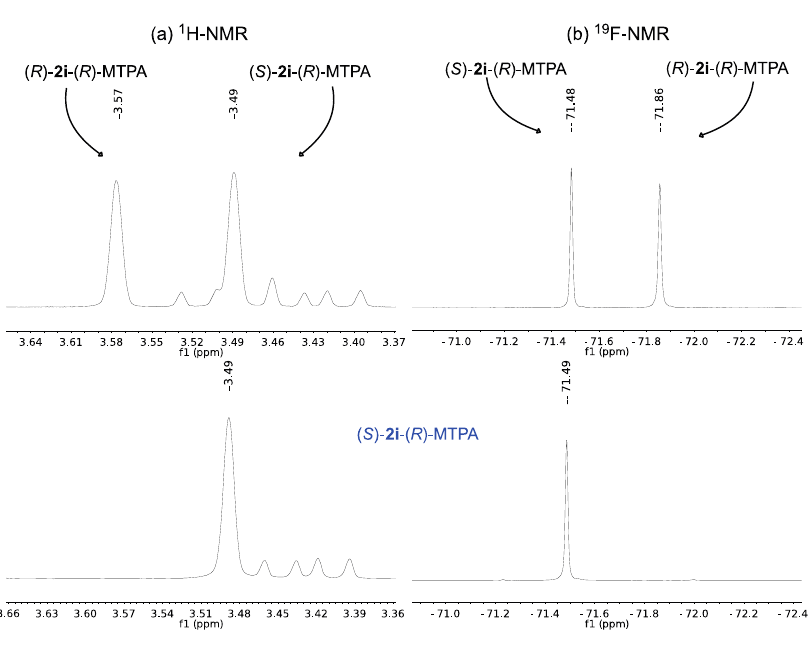
Figure 3. ( a ) 1 H-NMR of the methoxy region of ( R )-MTPA esters of rac - 2i (above) and ( R )-MTPA ester of ( S )- 2i (below); ( b ) 19 F-NMR of ( R )-MTPA esters of rac - 2i (above) and ( R )-MTPA ester of ( S )- 2i